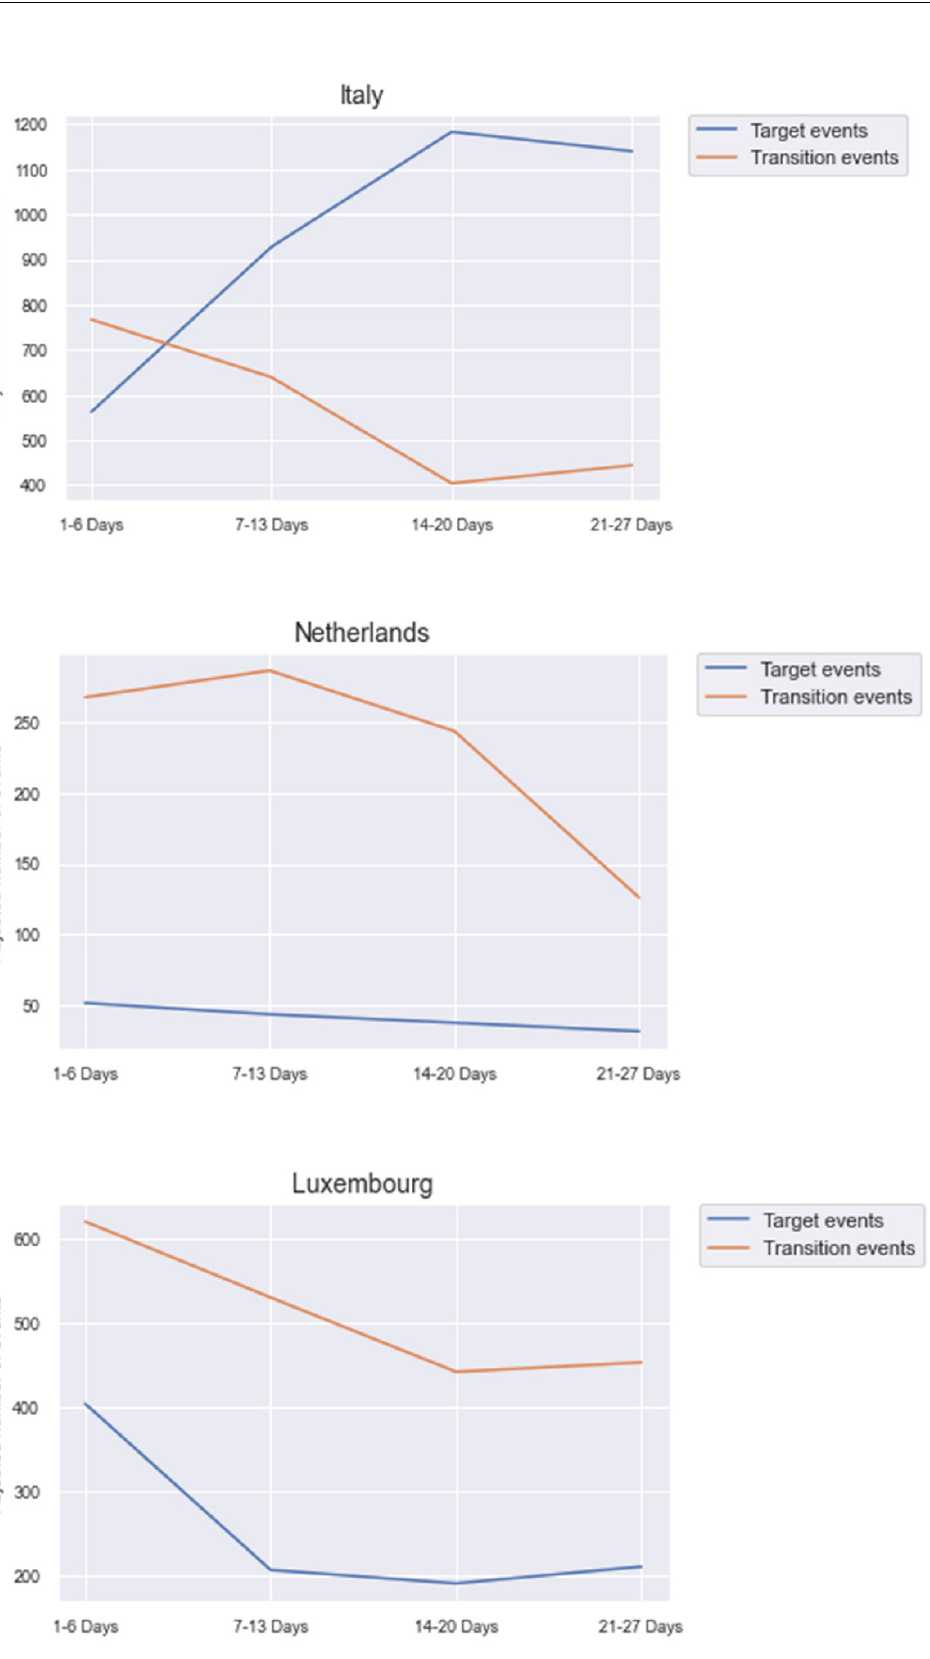
Figure 4. Transition and target events over time in the different countries (out of comparison reasons between the periods, the number of transition and target events were divided by the number of users in this period).